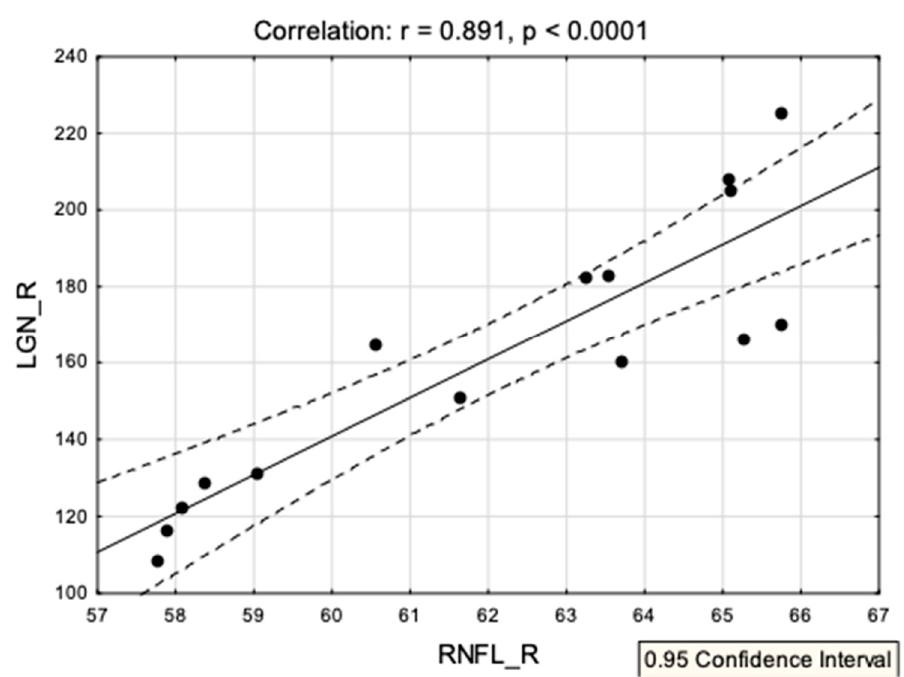
Figure 6. A correlation scatterplot showing associations between the volume of the right LGN and the right retinal nerve fiber layer in the LHON group.